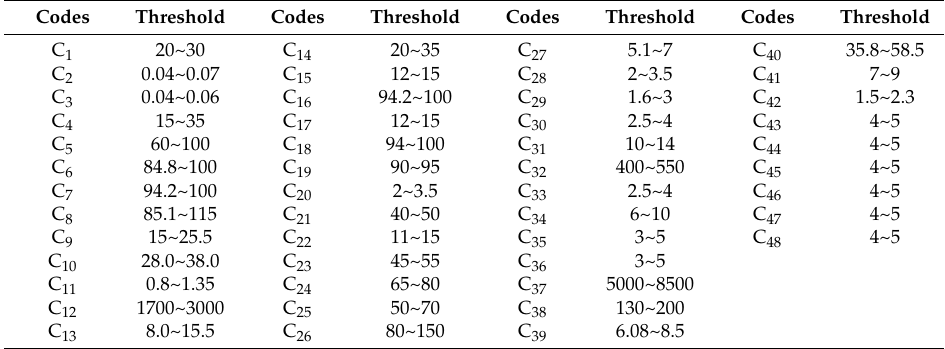
Table A2. Data of threshold interval of indicators.